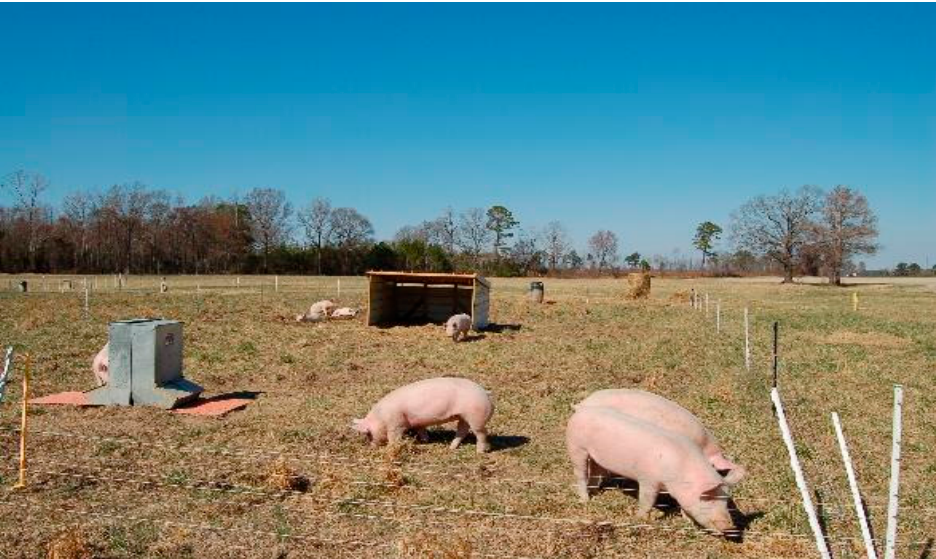
Figure 5. View of a Strip managed paddock during the first grazing period (December to March). In front are two two-space self-feeders, in the center of the strip the shelter, in the back the plastic barrel used as a drinker during winter.